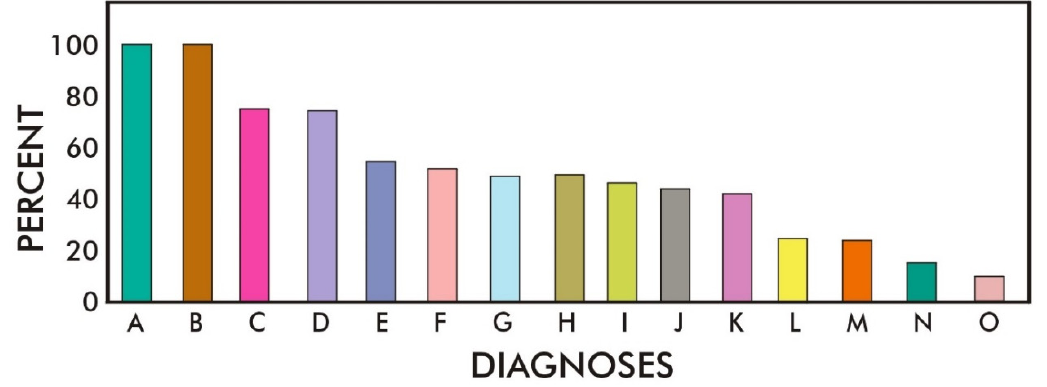
Figure 1. Diagnoses and/or symptoms of study participants reported after the 1991 Gulf War. All participants had multiple symptoms or diagnoses at various times before entering the trial. Percent of participants with: A: Gulf War illnesses, B: chronic fatigue syndrome, C: multiple chemical sensitivity syndrome, D: weight gain/loss, E: irritable bowel syndrome, F: fibromyalgia syndrome, G: allergies, H: skin rashes, I: depression, J: joint pain, K: hypertension, L: reactive airway symptoms, M: sleep disturbances, N: skin lesions, O: contact